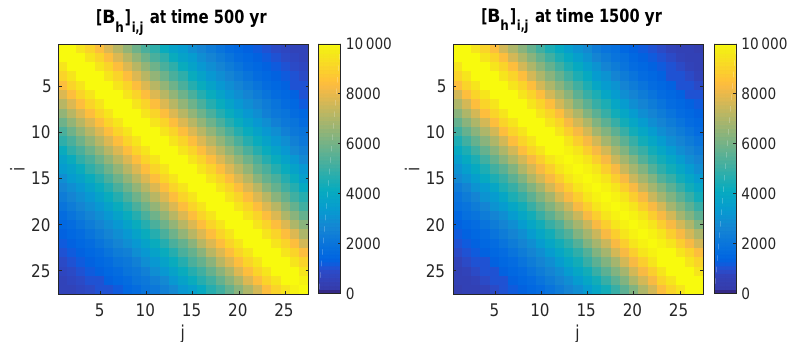
Figure 3. Covariance matrices for ice thickness variables B h used by the 3D-Var at assimilation times t 1 = 500 and t 2 = 1500 years. Co- variances between variables at distant locations tend to reduce between the two assimilation times. The distance between adjacent nodes also tends to be greater in the centre of the mesh than at the boundaries, leading to a decreasing covariance at t 2 = 1500 years in this area. (b) Evolution position margin (c) Evolution grid with 3D-Var